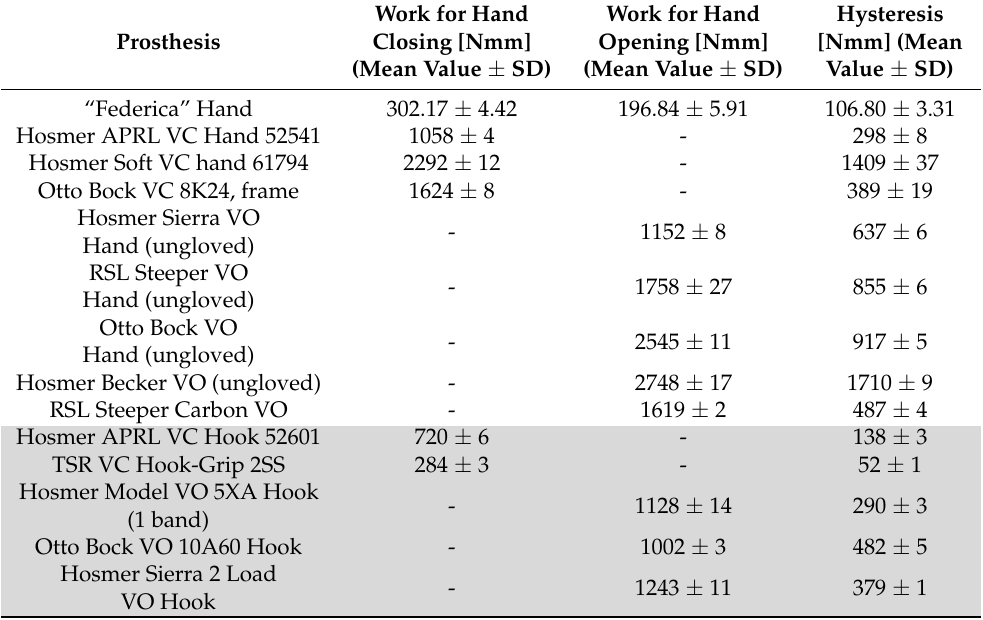
Table 4. Work for hand opening, closing and hysteresis [Nmm] of different body-powered hand/hook prostheses. The acronym VO stands for voluntarily open, while VC stands for voluntarily closed. The hook prostheses are highlighted with a grey background (Table extracted from